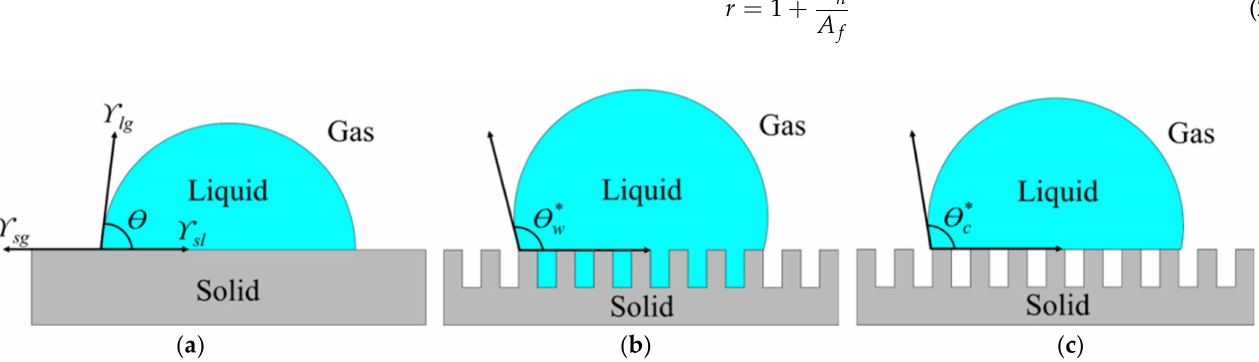
Figure 1. A liquid droplet resting on a solid surface and surrounded by a gas forms a characteristic contact angle θ . ( a ) Flat surface; ( b ) Rough surface at which the liquid is in intimate contact with the solid asperities, so that the droplet is in the Wenzel state; ( c ) Rough surface at which the liquid rests on top of the asperities, so that the droplet is in the Cassie-Baxter state [20,21]. Note that θ w * is the apparent contact angle of the textured surface based on the Wenzel model, θ c * is the apparent contact angle of the textured surface based on the Cassie-Baxter model, and γ sv , γ sl , γ lv is the surface tension between solid-gas, solid-liquid, and liquid-gas interfaces,